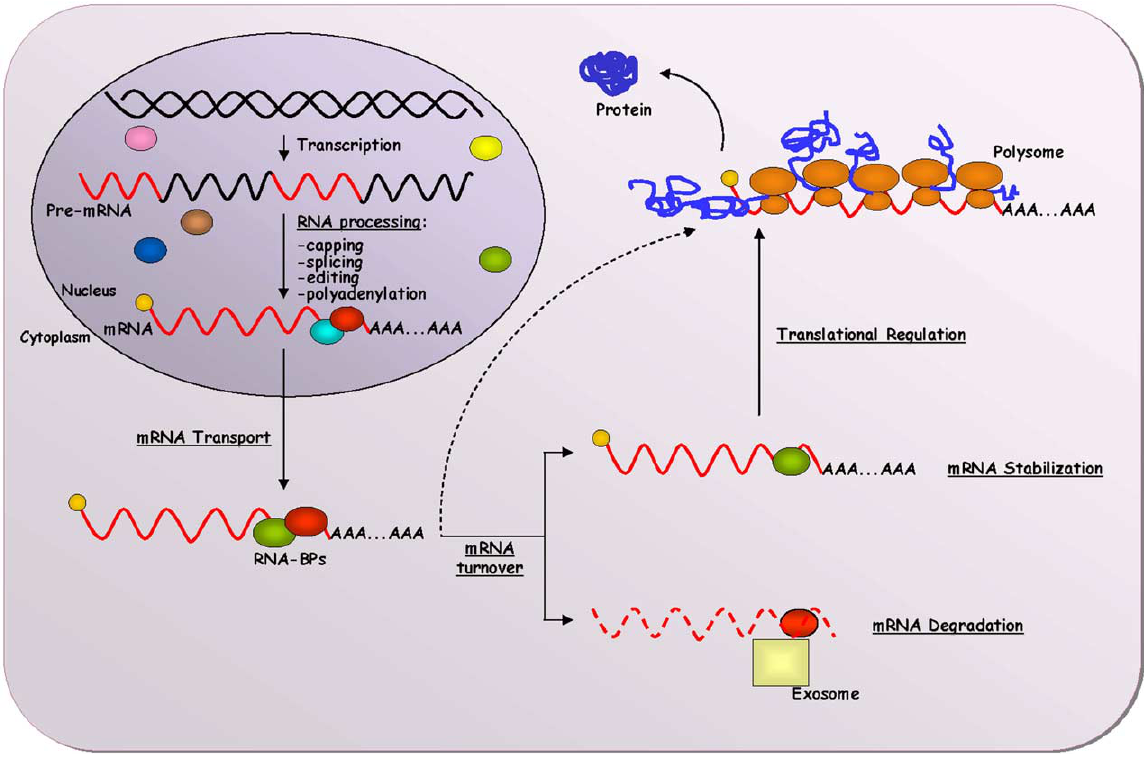
Fig. 1. Schematic of posttranscriptional gene regulation. During and after transcription, immature transcripts (pre-mRNA) are processed into the mature messenger (mRNA) within the nucleus. The maturation process consists of several steps including the addition of a 5 (cid:2) cap and a 3 (cid:2) poly-A tail, splicing to remove intronic regions and RNA editing. Then, the mature mRNA is transported into the cytoplasm where it is the subject of mRNA turnover processes (mRNA stabilization or mRNA degradation); if the mRNA remains undegraded, it is then recruited to the polysomes for